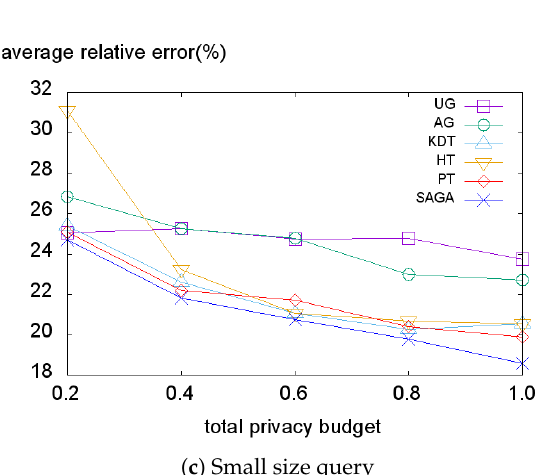
Figure 10. Average relative error on the Foursquare